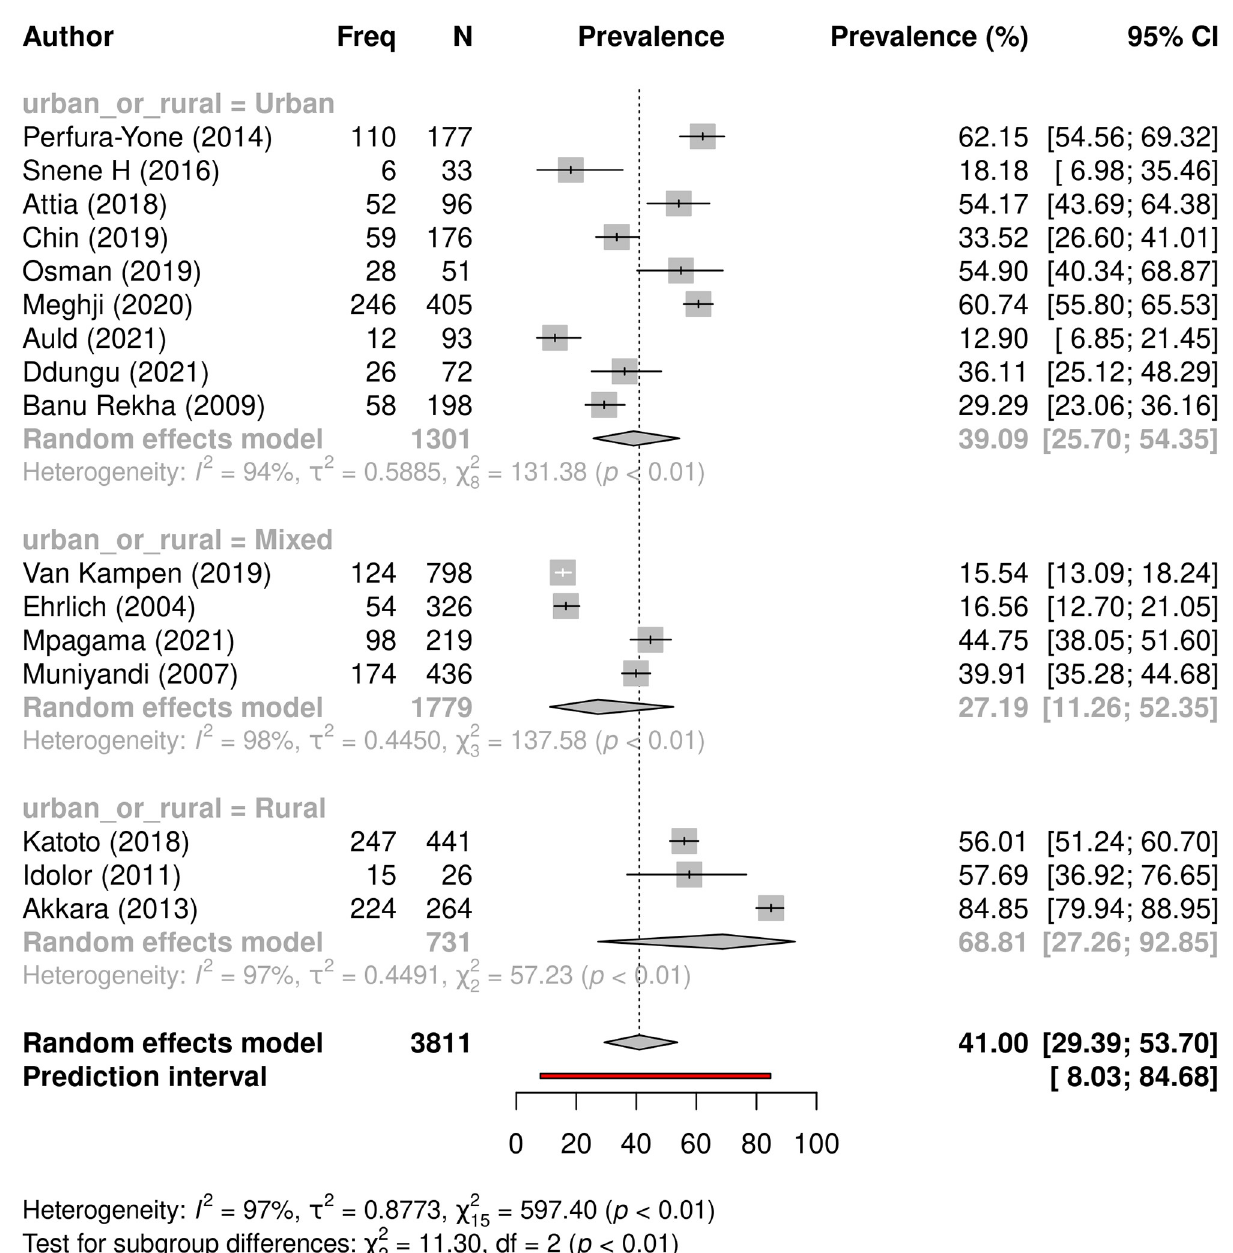
Fig 6. Prevalence of persisting respiratory symptoms in urban, mixed, and rural settings. A forest plot showing subgroup meta-analyses comparing prevalence of persisting symptoms following TB treatment across rural versus mixed versus urban settings.